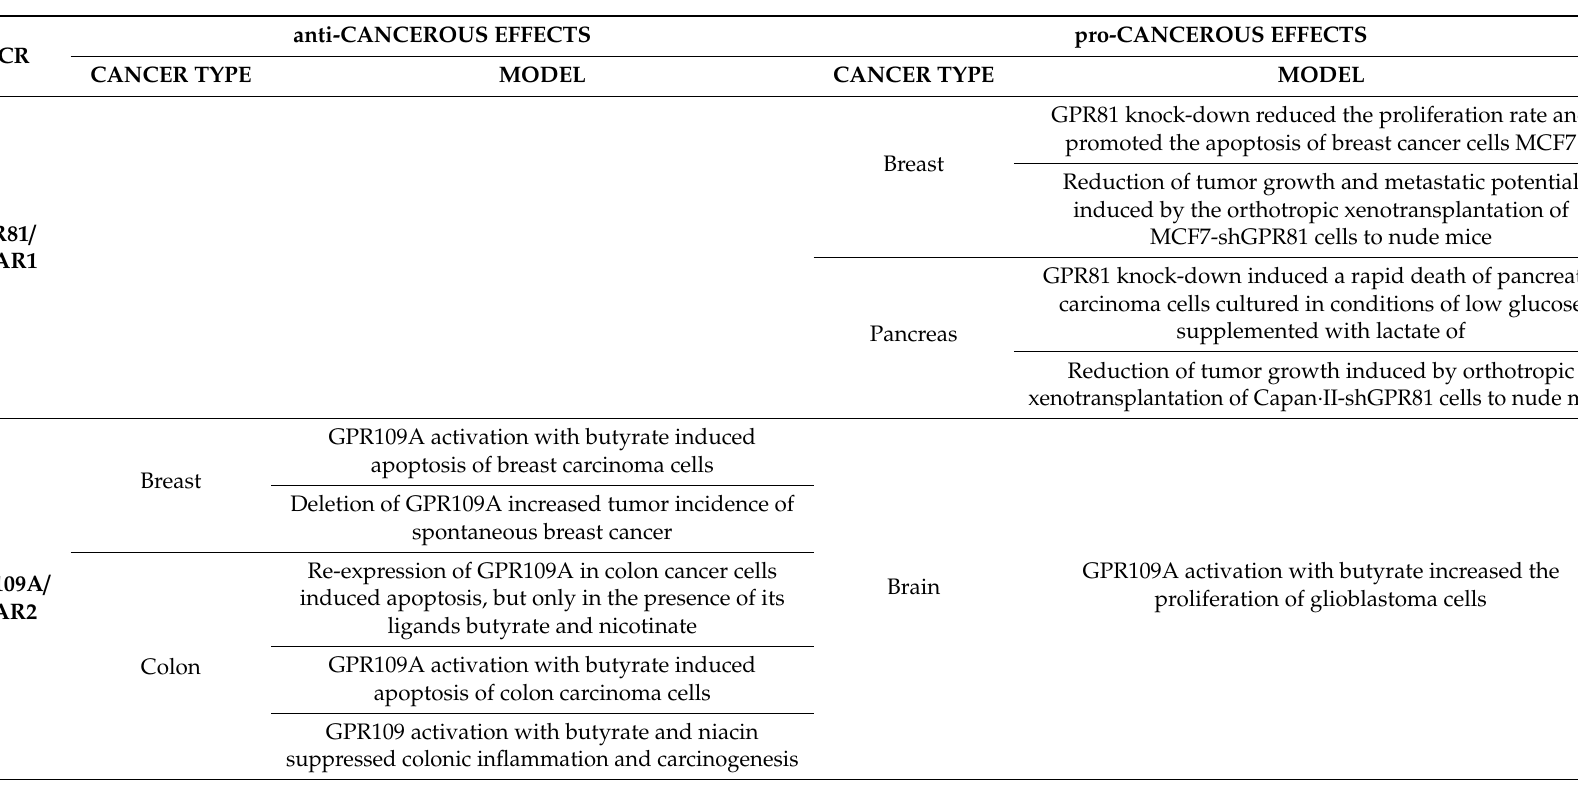
Table 4. Functional studies performed describing the role of the hydroxycarboxylic acid receptors (HCAR) in several types of cancers. This table includes the literature which demonstrates the anti-cancerous and pro-cancerous role of each hydroxycarboxylic acid receptor in both in vitro cells or in vivo with